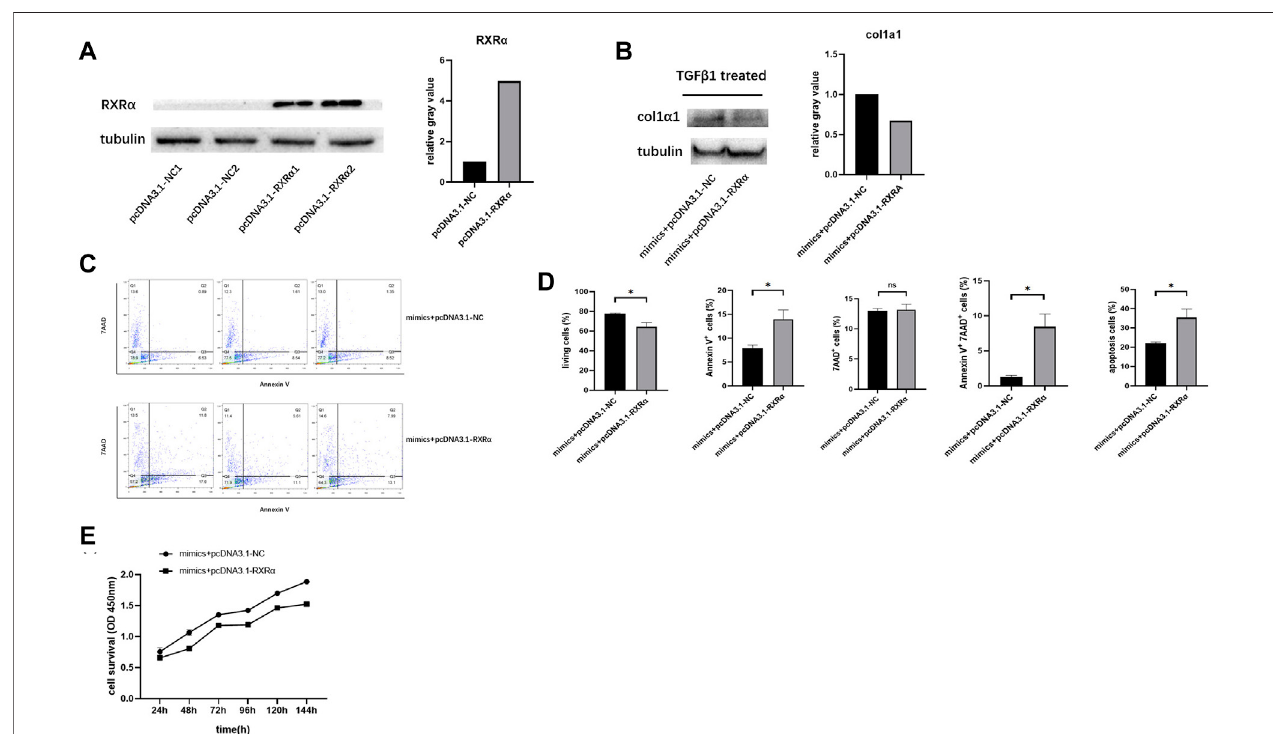
FIGURE 5 | RXR α overexpression rescues the effect of miR-654-5p on LX-2 cells. (A) Expression level of RXR α protein in cells transfected with pcDNA3.1- RXR α plasmid or the corresponding negative control, grey values are measured through ImageJ (B) Expression level of col1 α 1 protein in LX-2 cells co-transfected with miR-654-5p mimics and pcDNA3.1-NC/pcDNA3.1-RXR α plasmid, grey values are measured through ImageJ. (C) Combined effects of the hsa-miR-654-5p mimic and pcDNA3.1-NC/pcDNA3.1-RXR α on LX-2 cell apoptosis (D) Flow cytometric analysis to determine the ratio of apoptotic cells. After co-transfection with the hsa-miR-654-5p mimic and pcDNA3.1-NC/pcDNA3.1-RXR α , cells were cultured in an FBS-free medium for 5 days. (E) Cell proliferation evaluated via CCK-8 assay after co-transfection with the miR-654-5p mimic and pcDNA3.1-NC/pcDNA3.1- RXR α . Error bars represent mean ± SEM of at least three independent experiments. * p <